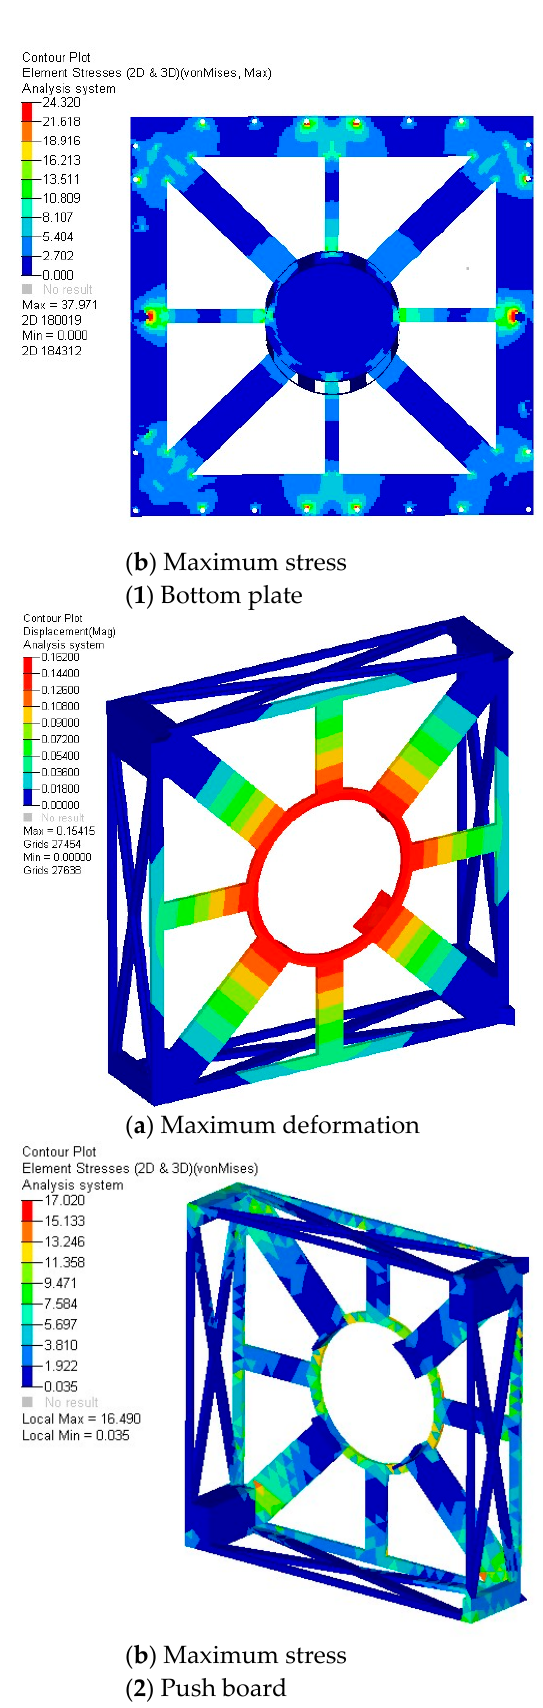
Figure 8. Quasi-static acceleration analysis results.